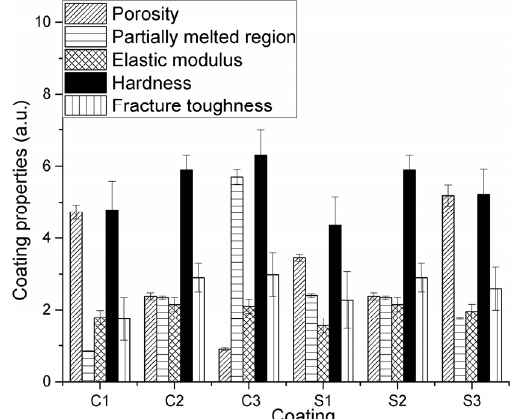
Fig. 4 Relative comparison of mechanical properties of chromia coatings.